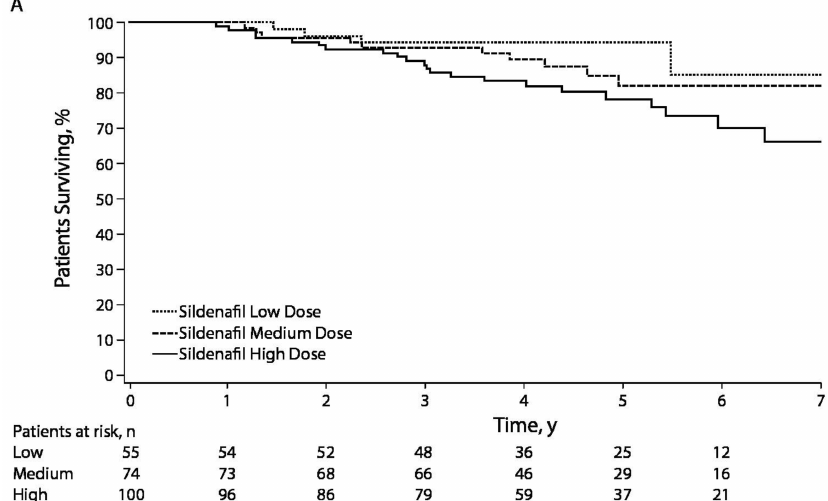
Figure 13. Kaplan–Meier estimated survival from start of sildenafil treatment in Sildenafil in Treatment-Naive Children, Aged 1 to 17 Years, With Pulmonary Arterial Hypertension (STARTS-1) and STARTS-2. Patients were censored at the last date they were known to be alive; if a patient received a transplant, he or she was censored the day before transplant. Patients at risk are those who are ongoing in the study or known to be alive at the specified time (i.e., not dead, not lost to follow-up, or not in study long enough to reach time point)